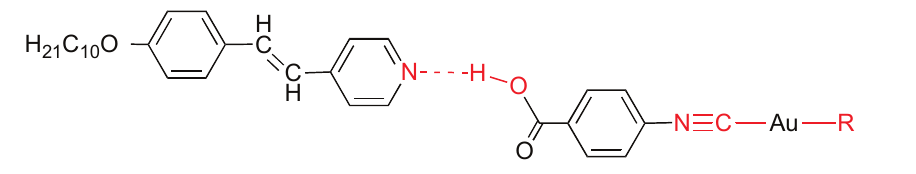
Figure 26. Supramolecular H-bond mesogens. R = Cl, C